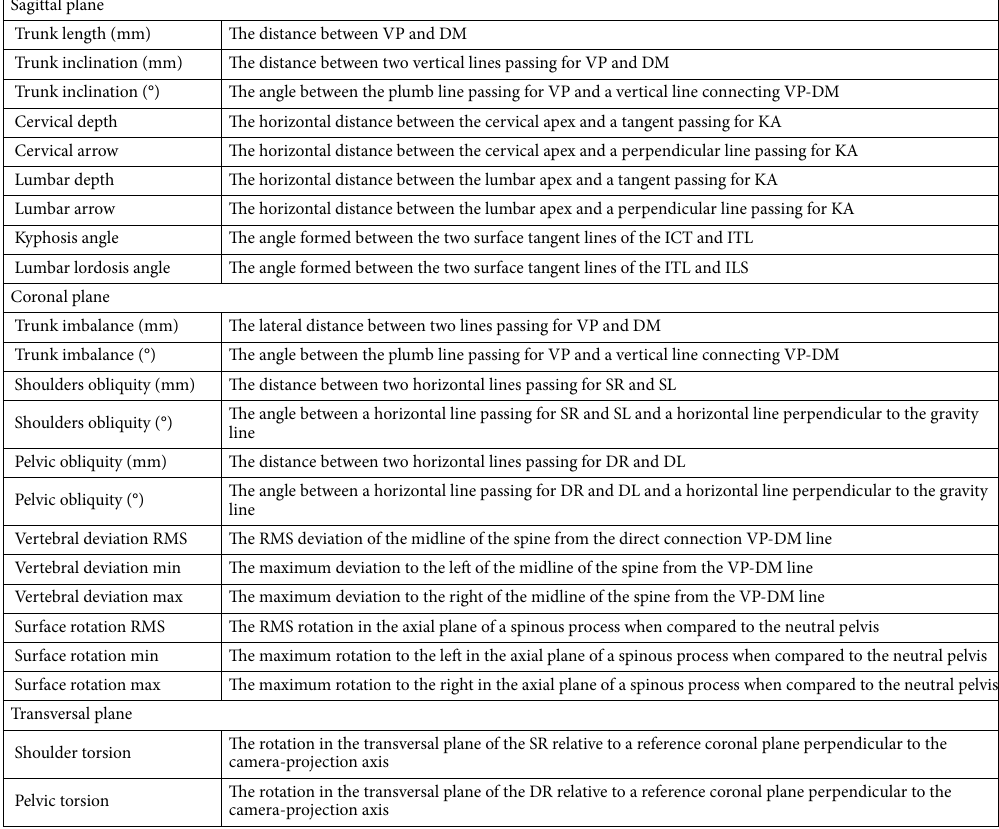
Table 4. Description of rasterstereography parameters. VP vertebra prominent, DM dimple midpoint, KA kyphotic apex, ICT inflection point between cervical and thoracic spine, ITL inflection point between thoracic and lumbar spine, ILS inflection point between lumbar spine and sacrum, SR shoulder right, SL shoulder left, DR dimple right, DL dimple left, RMS root mean